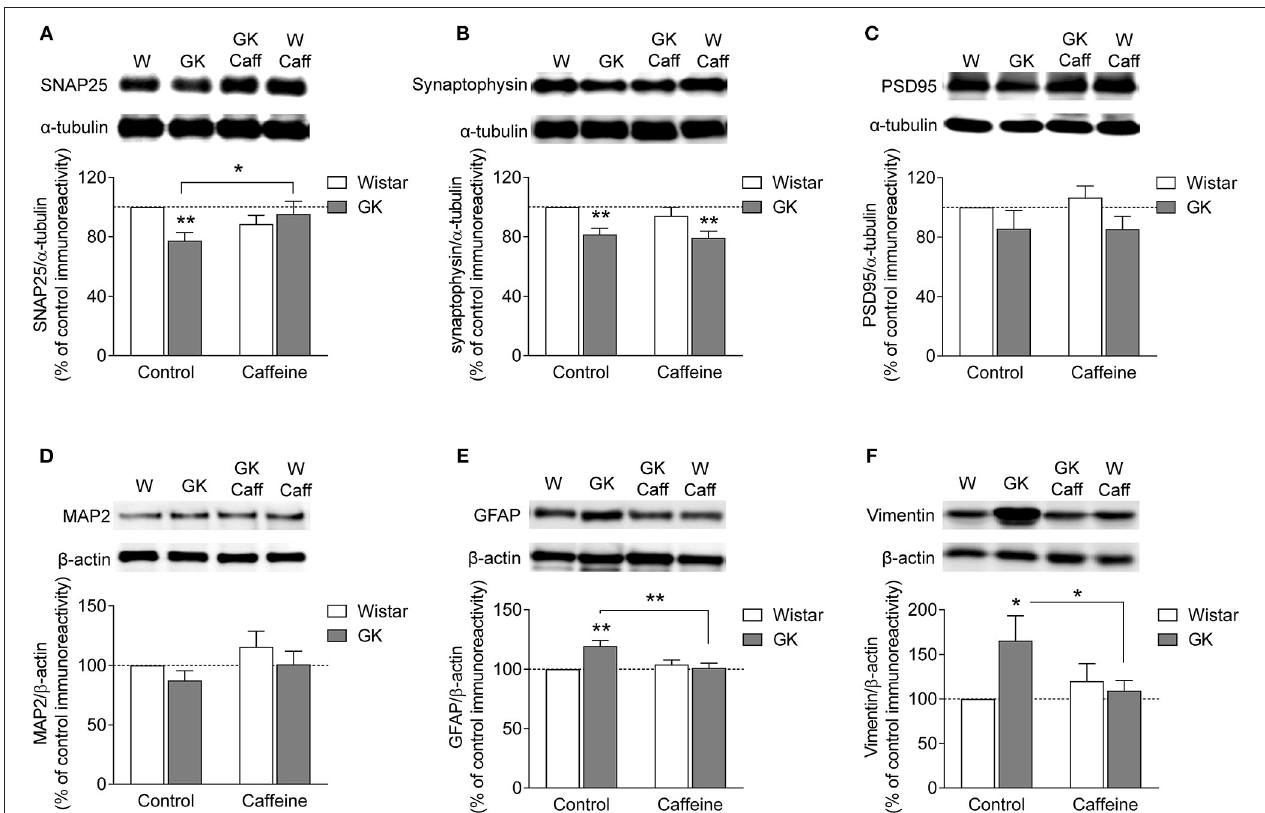
FIGURE 5 | Caffeine consumption attenuated diabetes-induced synaptic degeneration and prevented astrogliosis in the hippocampus of GK rats. Western blot analysis revealed that hippocampal synaptosomal membranes from diabetic GK rats displayed reduced immunoreactivity of both SNAP25 (A) and synaptophysin (B) but not PSD95 (C) , when compared to Wistar rats (W). In total hippocampal membranes, diabetes failed to alter MAP2 immunoreactivity relative to controls (D) . Caffeine (Caff) consumption prevented diabetes-induced reduction of SNAP25 but not synaptophysin. Western blot analysis revealed that both GFAP (E) and vimentin (F) immunoreactivity was increased in total hippocampal membranes from GK compared to control rats, an effect prevented by the consumption of caffeine. Samples were loaded in the SDS-PAGE gel at a protein concentration of 25 µ g. Immunoreactivity of proteins of interest was normalized to either α -tubulin or β -actin, and expressed as percentage of control in the same Western blot experiment. In the graphs, open and filled bars represent Wistar and GK rats, respectively. Data are mean ± SEM of n = 5–8 animals per experimental group. Symbols represent LSD test results after ANOVA with either significant diabetes effect or significant diabetes-caffeine interaction: * P < 0.05, ** P < 0.01 for GK vs. Wistar in the respective treatment group or as